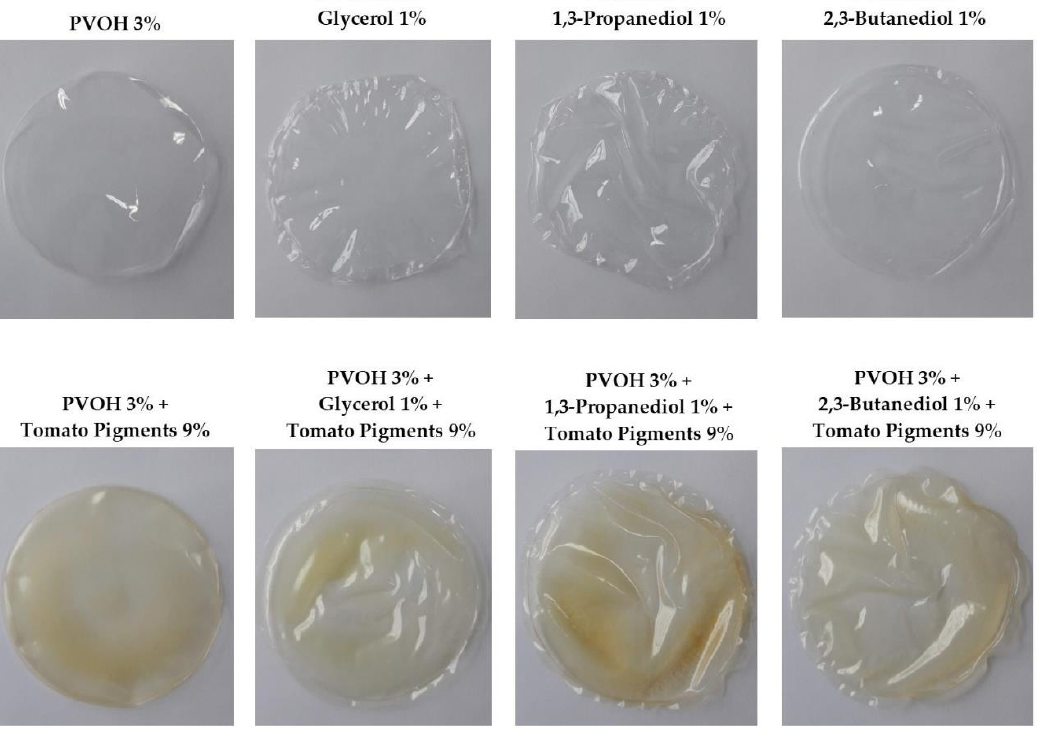
Figure 5. PVOH-based biofilms plasticized with polyols and colored with tomato-based pigments.